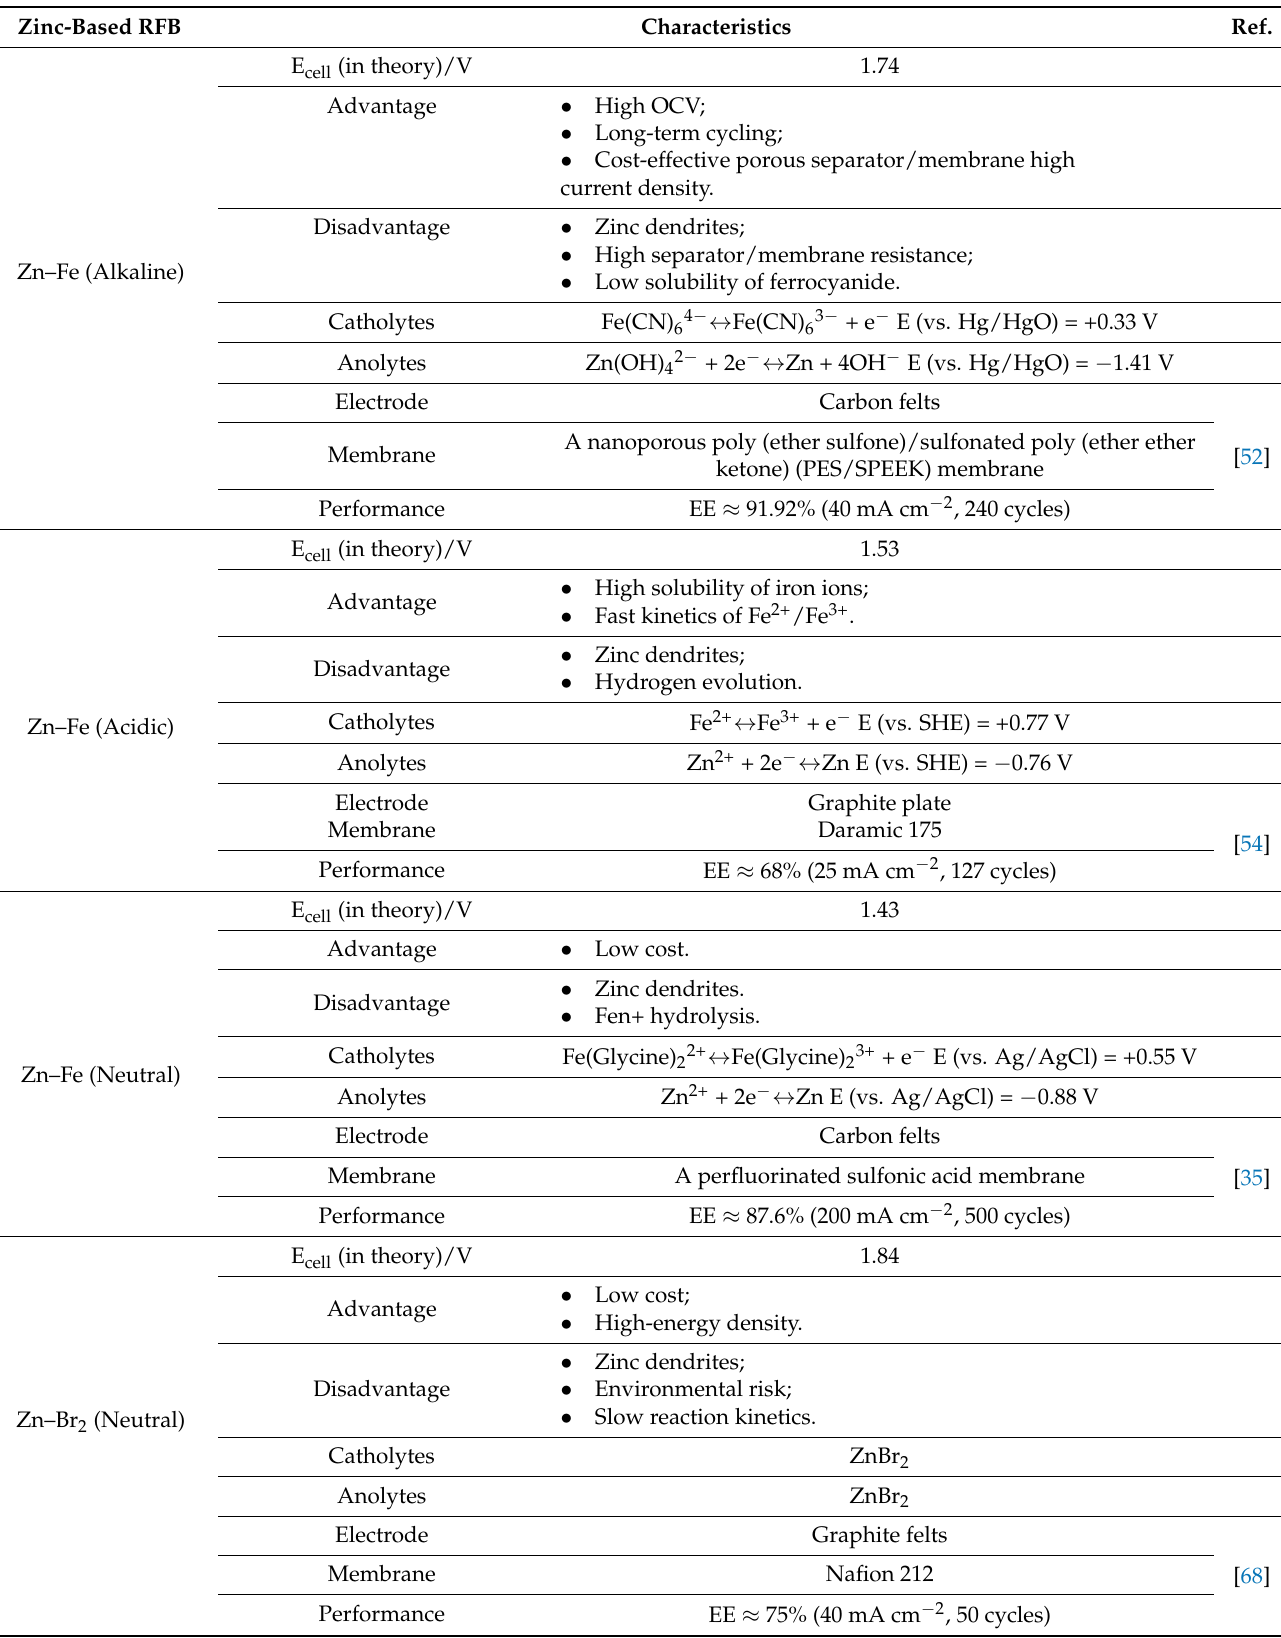
Table 3. The difference in various zinc-based